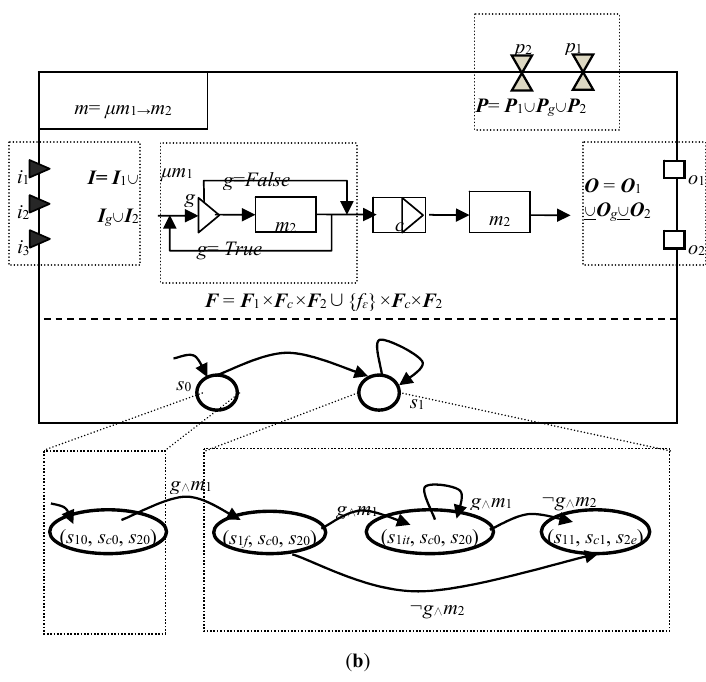
Figure 12. The diagram definition of M → μ M . ( a ) M → Μ m; ( b ) μ M → M.